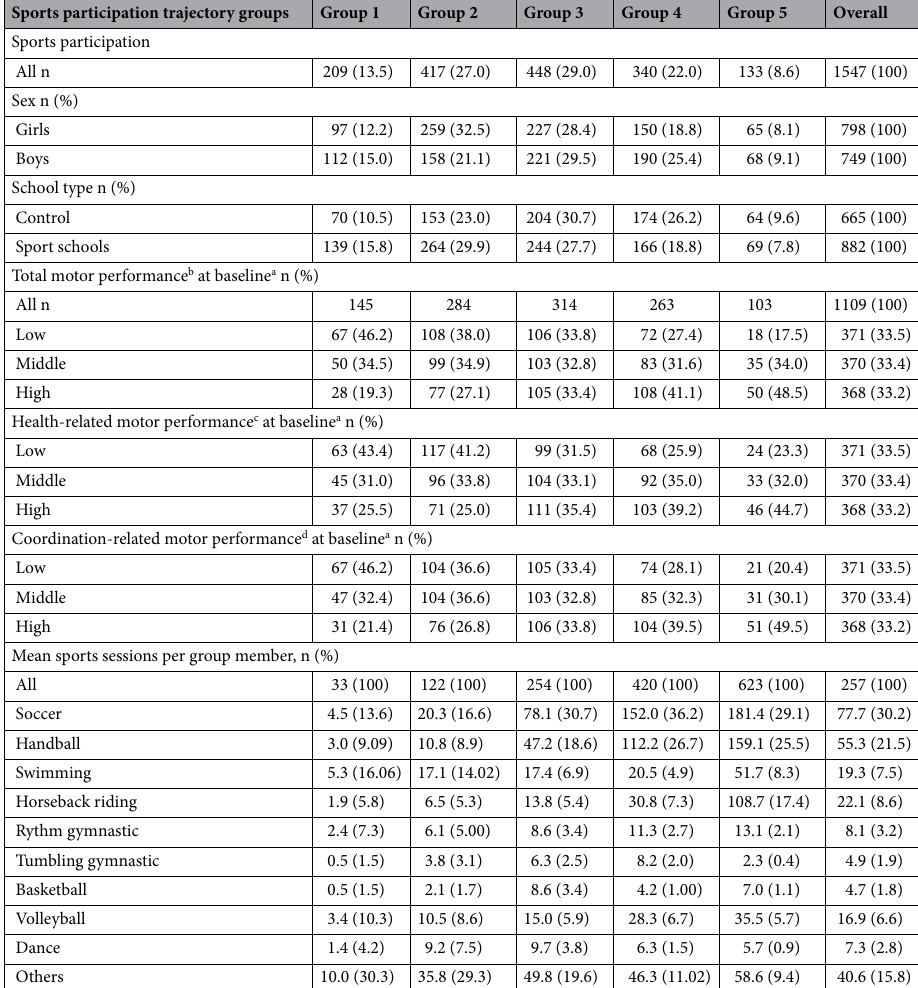
subgroup of individuals with the highest activity level. The z-score was multiplied by -1 if a better performance meant a lower values. The health-, coordination- and total score were then calculated by summing the relevant variables z-scores and then divided by the number of included variables. a Motor performance scores were based on calculated z-scores. Z-score = (variable value – mean of values)/SD. b Including all 6